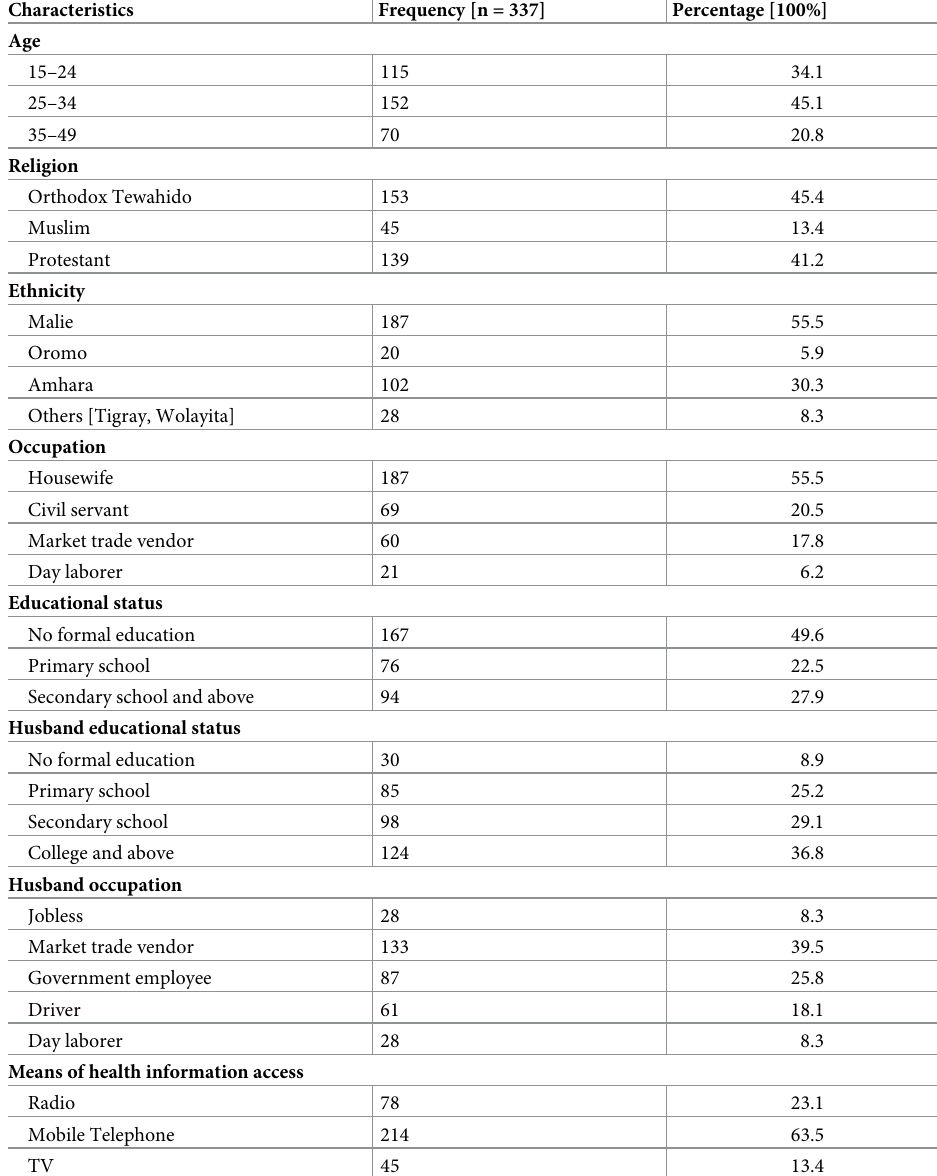
Table 1. Socio-demographic characteristics of child-bearing age women [15–49 years] in Jinka town, Southern Ethiopia, 2018 [n = 337].